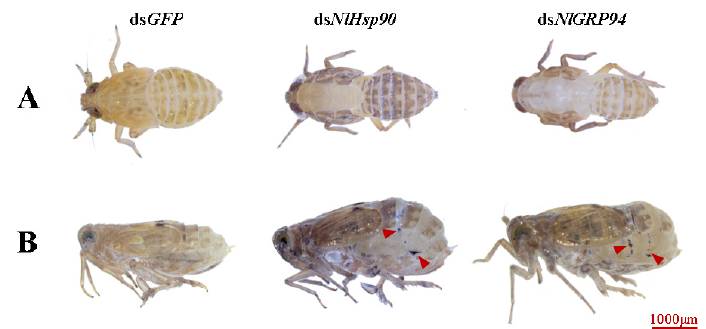
Figure 6. Phenotypes of N. lugens injected with ds NlHsp90 and ds NlGRP94 . ( A ) Influence of ds NlHsp90 and ds NlGRP94 on the development of nymphs. Most nymphs died during molting. ( B ) The phenotype of ds NlHsp90 and ds NlGRP94 females 6 days after injection, with stretched intersegmental membranes and scars in the abdomen. The black scar in the abdomen is indicated by arrowheads. ds GFP was injected as a negative control.